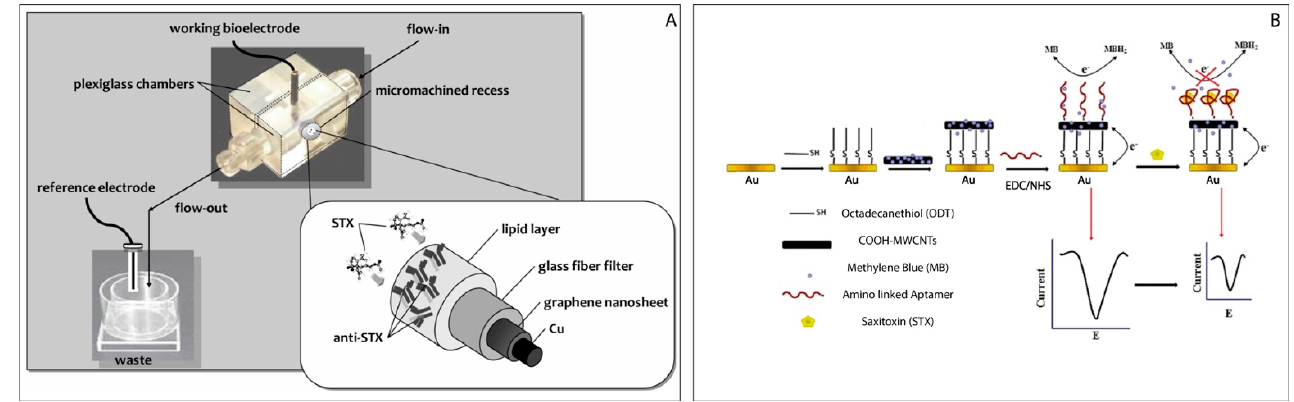
Figure 4. ( A ) Schematic representation of the potentiometric sensor based on graphene sheets for saxitoxin detection. Reprinted with permission from Ref. [62]. Copyright 2016, Wiley; ( B ) The schematic diagram of amperometric aptasensor for saxitoxin using a gold electrode modified with carbon nanotubes on a self-assembled monolayer, and Methylene Blue as an electrochemical indicator probe. Reprinted with permission from Ref. [63]. Copyright 2016,